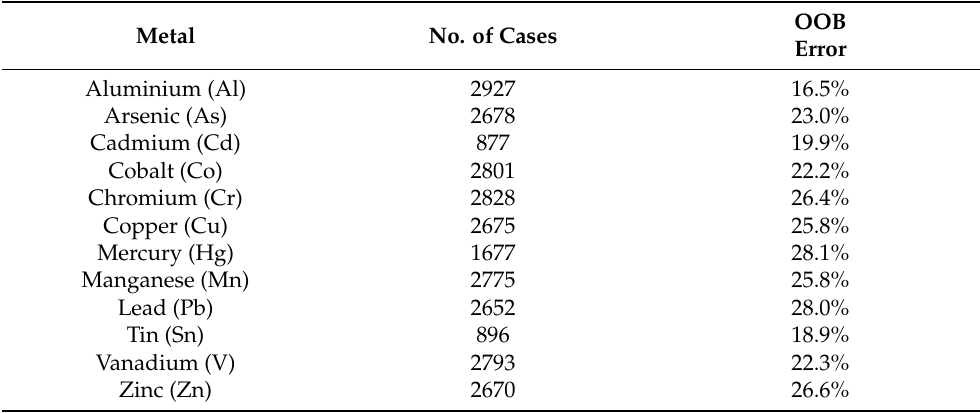
Table 2. The number of cases per metal and the out-of-bag